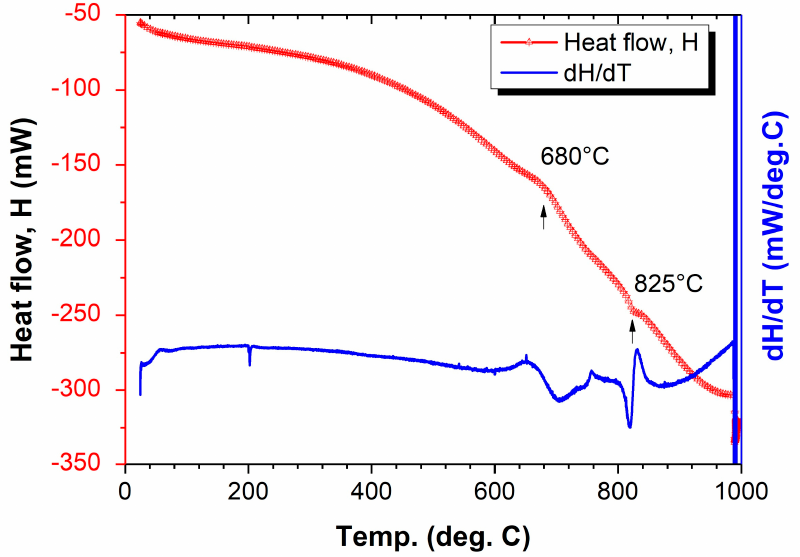
Figure 4. Di ff erential thermal analysis (DTA) curve of the as-cast